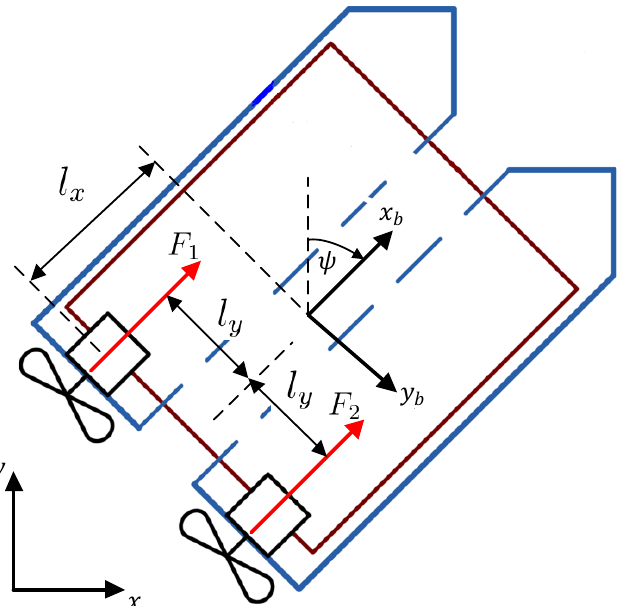
Figure 1. Earth- and body-fixed coordinate systems for the definition of state variables of a